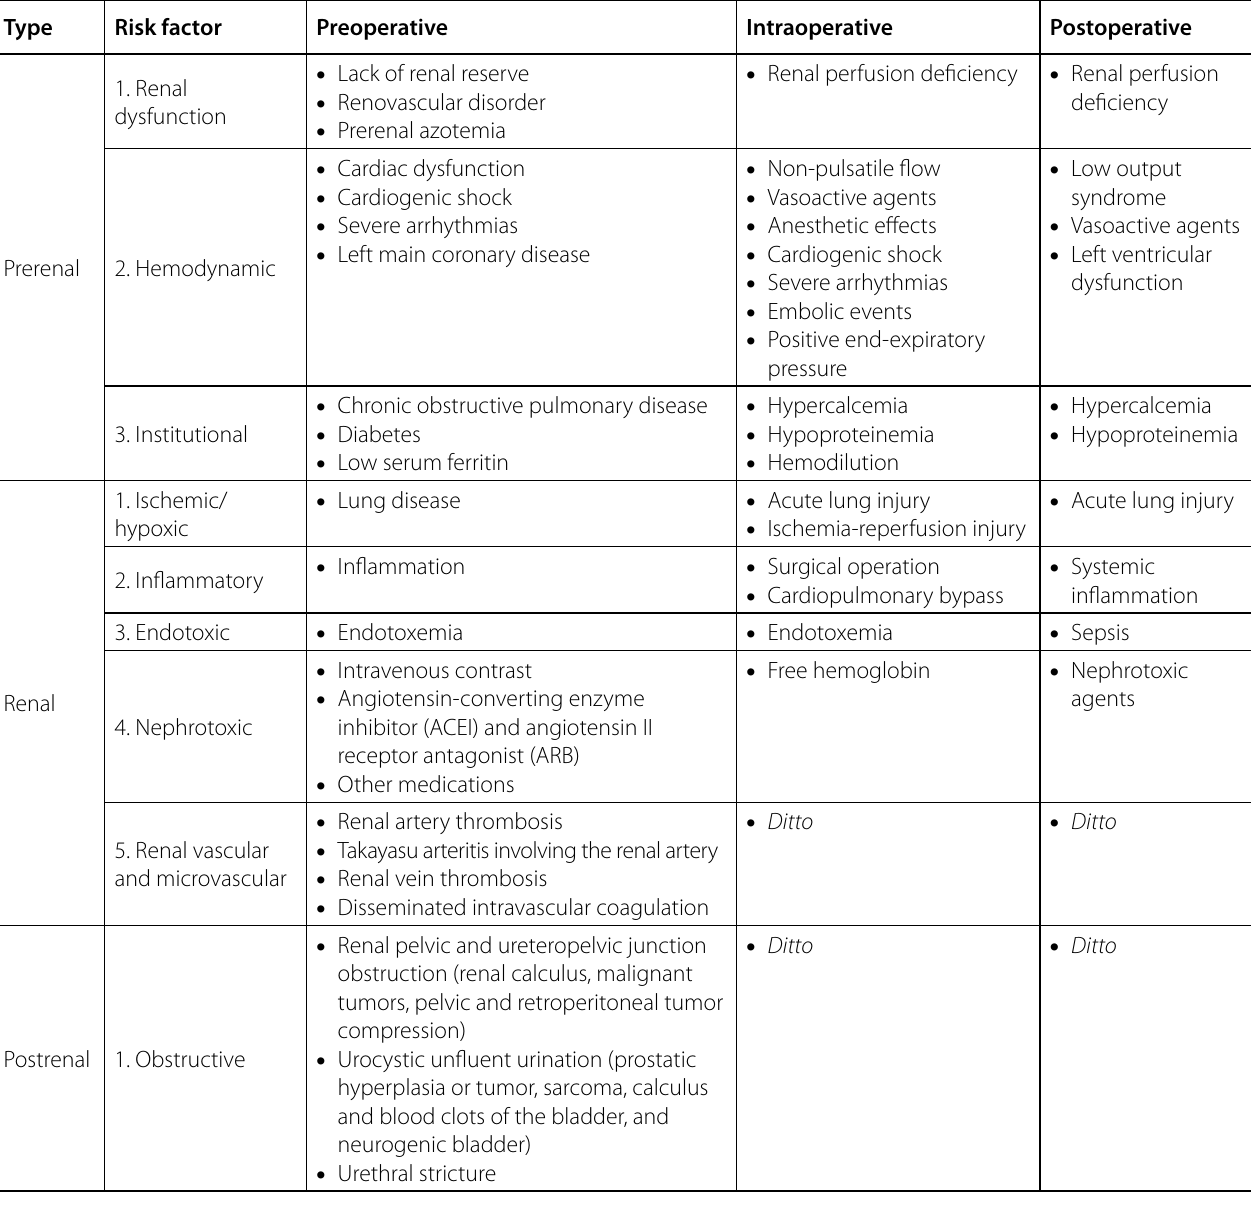
Table 2. Predictive risk factors of acute renal failure after cardiac